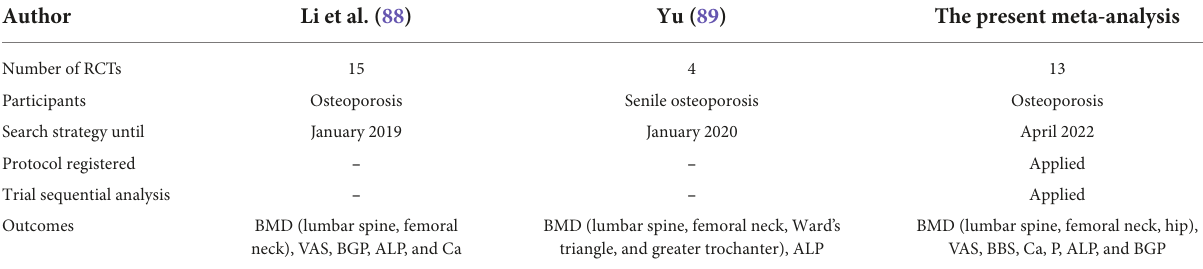
TABLE 4 Comparison with other previous